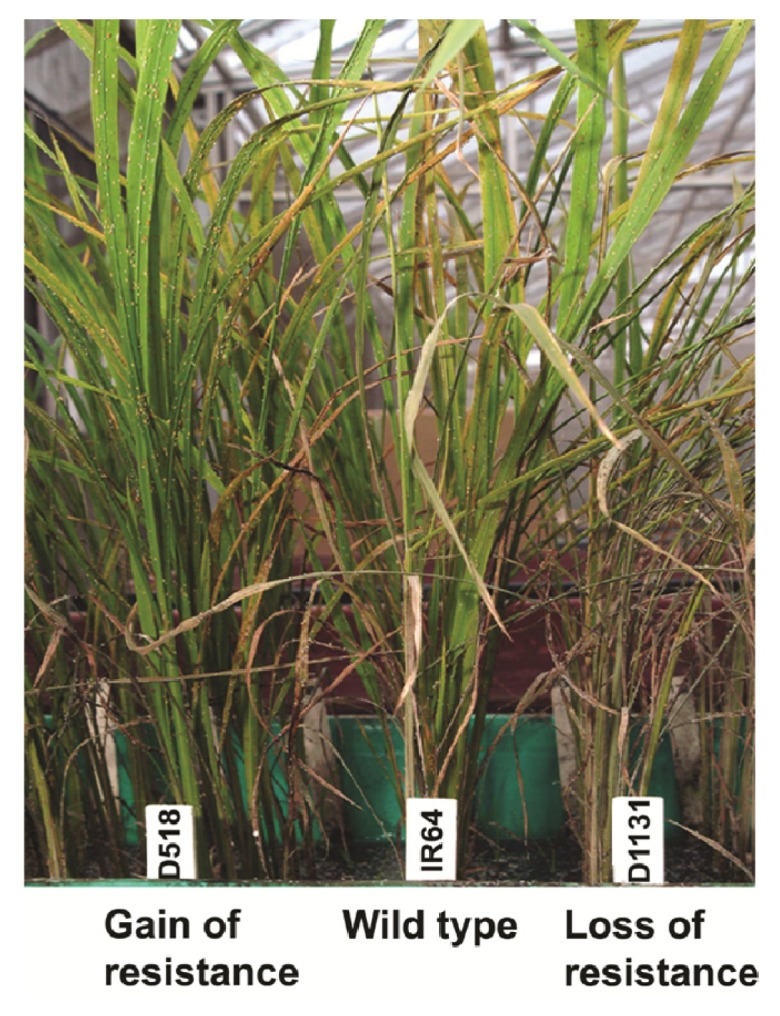
Phenotype of wild type IR64 and mutant plants exposed to brown planthopper (N. lugens) infestation under greenhouse conditions during seedbox screening (free choice). Pre-germinated seeds were sown in the heat sterilized soil in seed boxes a density of 15 seedlings per row. Hopperburn symptoms appeared first on D1131, followed by IR64 and lastly on D518. The experiment was repeated 3 times.